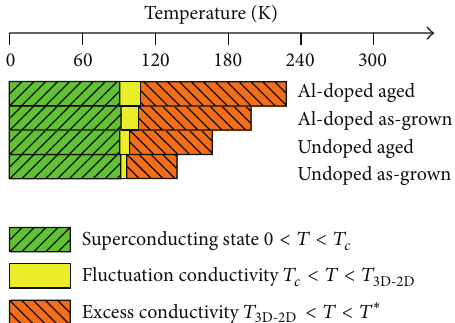
Figure 4: The impact of aluminum doping and prolonged aging on the implementation of the different conductivity regimes for the investigated single crystals of